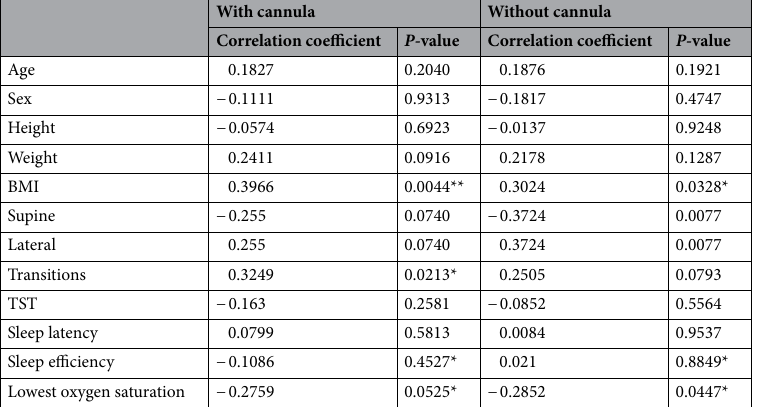
Table 4. Correlation analysis of AHI differences derived from polysomnographic data versus infrared optical gas imaging data (Alo data). AHI apnea–hypopnea index, BMI body mass index, TST total sleep time. * P < 0.05, ** P <